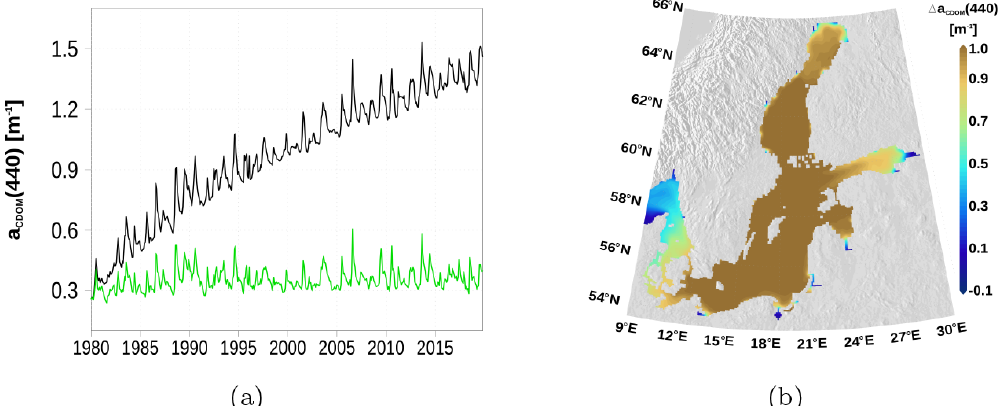
Figure A1. The effect of photobleaching on CDOM absorption. The black line in (a) is from the model without photobleaching at station BY15 (Fig. 8). In (b) the difference in 2018 of the surface CDOM absorption is shown (without photobleaching minus control run). Simulated CDOM concentrations have been converted into absorption. The map was created using the software package GrADS 2.1.1.b0 (http://cola. gmu.edu/grads/, last access: 6 August 2021), using published bathymetry data (Seifert et al.,